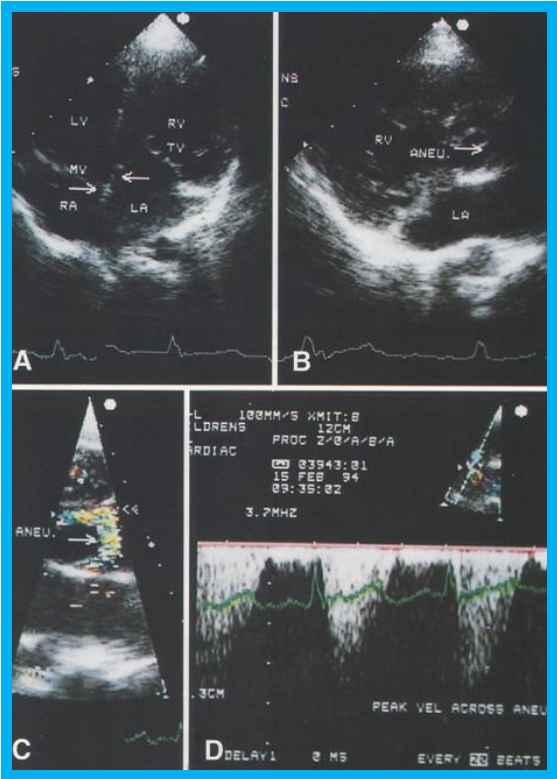
Figure 17. ( A ) Selected video frame from apical four chamber projection indicating reversal of the ventricles: The attachment of the mitral valve (MV) leaflet is higher than that of the tricuspid valve (TV), suggesting that the morphologic right ventricle (RV) is on the left side and that the morphologic left ventricle (LV) is on the right side. The right atrium (RA) drains into morphologic LV, and the left atrium (LA) is connected to the morphologic RV. Also note that the medial leaflet of the TV is plastered on to the ventricular septum suggesting Ebstein’s type of morphologic TV. ( B,C ) Selected video frames from parasternal long axis view demonstrate the aneurysm (Aneu) with color-Doppler turbulence ( C ). ( D ) This frame shows a high peak Doppler flow (3.5 m/s), which indicates a peak instantaneous gradient of 49 mmHg. Reproduced from Reddy S.C.B., et al [22].